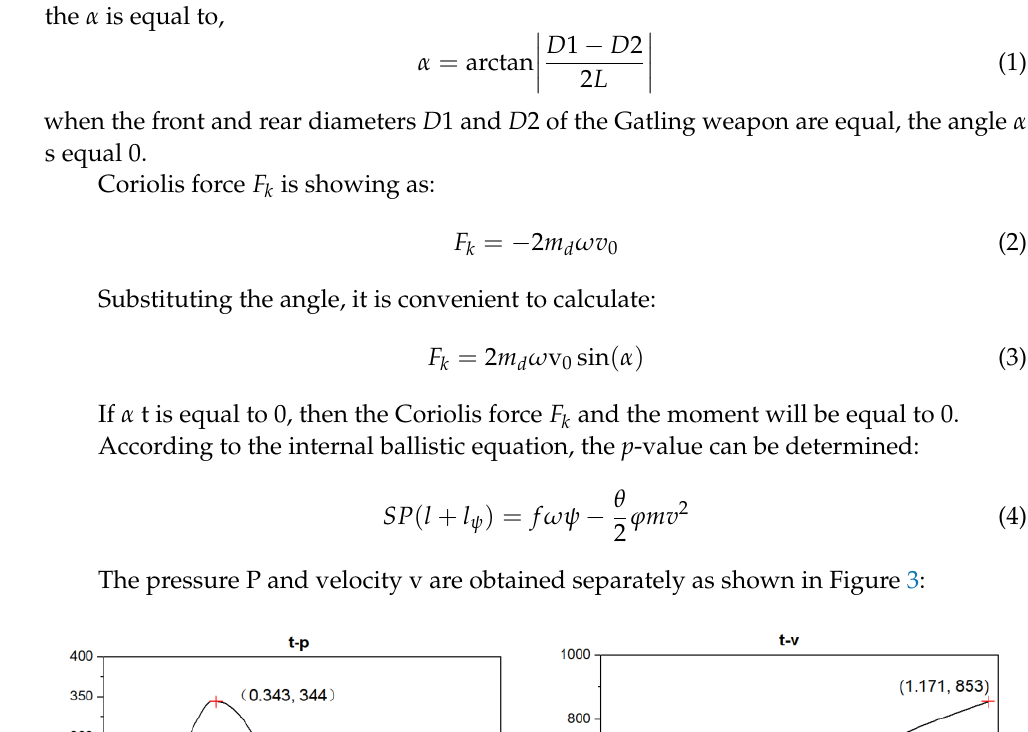
Figure 2. Gatling gun’s barrels. When the front and rear diameters D 1 and D 2 of the Gatling weapon are not equal, the α is equal to, when the front and rear diameters D 1 and D 2 of the Gatling weapon are equal, the angle α s equal 0. F is showing as: Coriolis force k